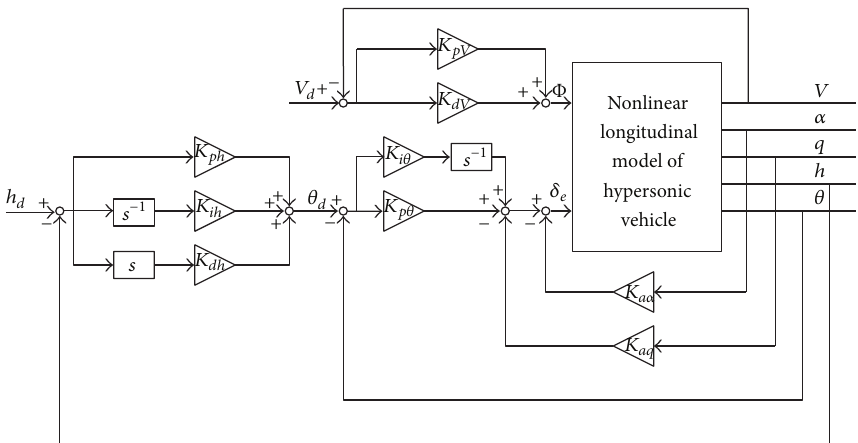
Figure 5: Control block diagram of hypersonic